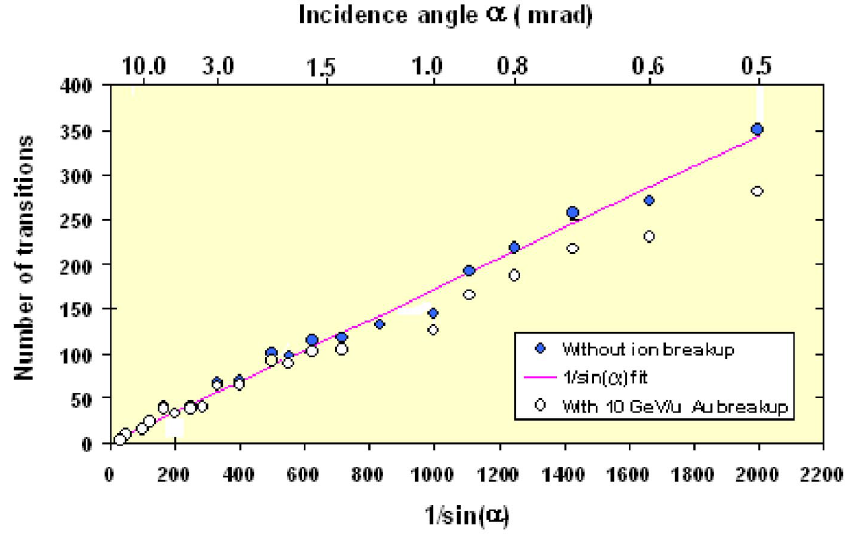
surface.FIG. 8. (Color) Number of vacuum-solid and solid-vacuum transitions for an ion impinging on the surface characterized by the profile of Fig. 7 as function of incidence angle. These numbers corrected for gold ion breakup are also